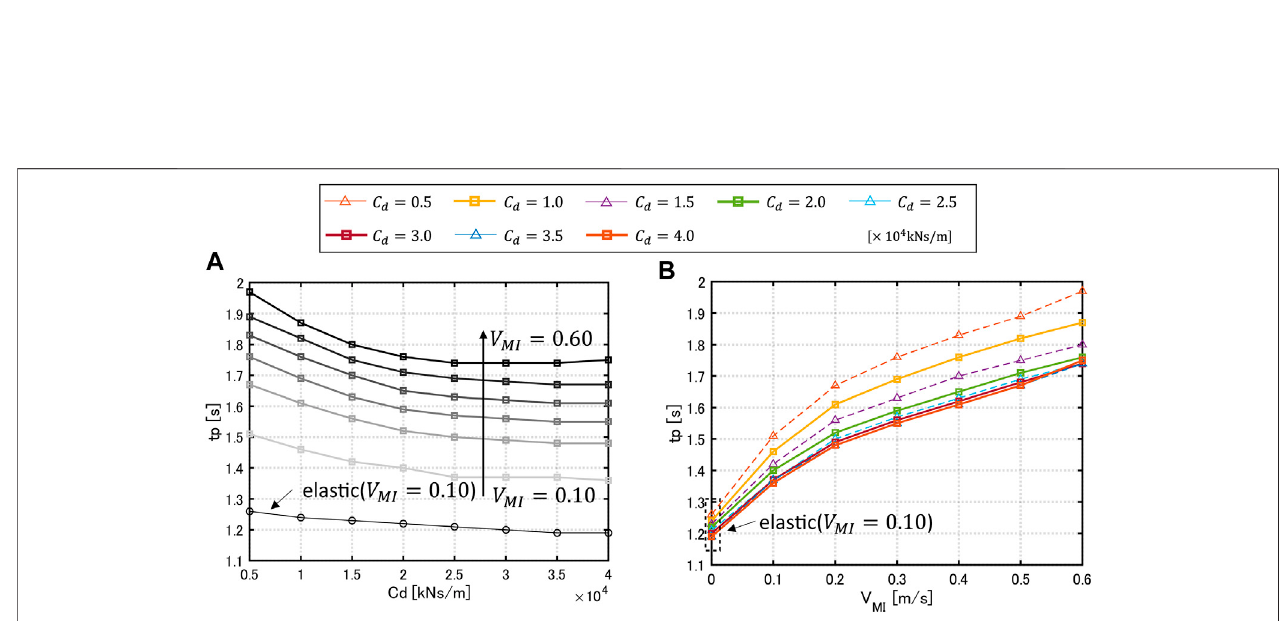
FIGURE 14 | Resonant period of multi impulse with respect to damper quantity and input velocity, (A) With respect to damper quantity, (B) With respect to input velocity.